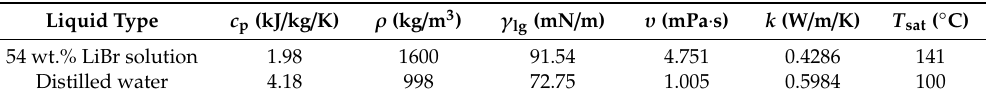
Figure 1. Overview of the experimental setup, including environmental chamber, charge-coupled device (CCD) camera, IR camera, back light, stainless steel vertical platform, droplet dosing system, and data acquisition system with ImageJ ® and Matlab ® . Table 1. Properties of 54 wt. % LiBr solution and distilled water as: specific heat capacity c p (kJ / kg / K); density ρ (kg / m 3 ); liquid-gas surface tension γ lg (mN / m); viscosity υ (mPa · s); thermal conductivity k (W / m / K); and saturation temperature T sat ( ◦ C). Properties shown were obtained at 20 ◦ C and at 1 atm.